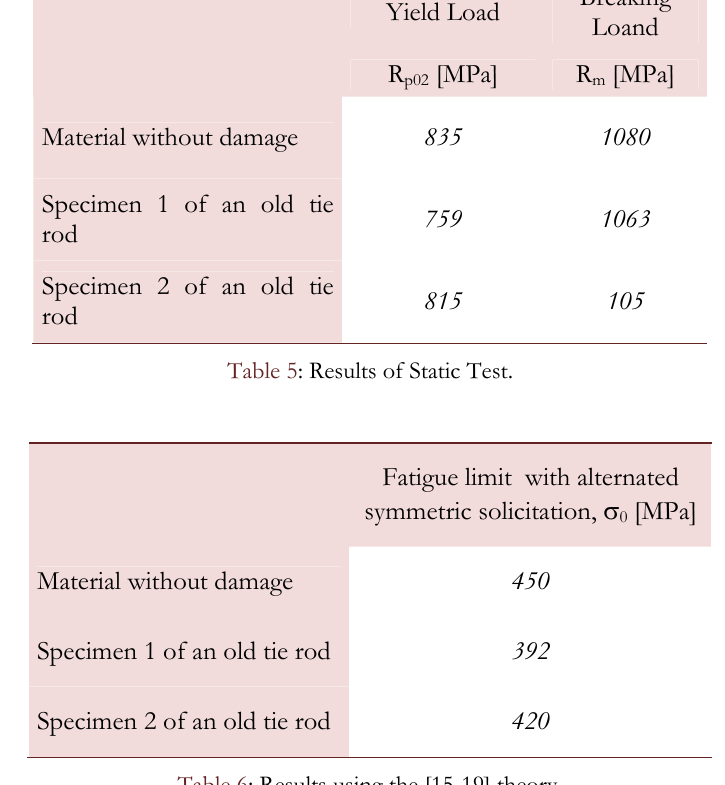
Table 6: Results using the [15-19] theory.